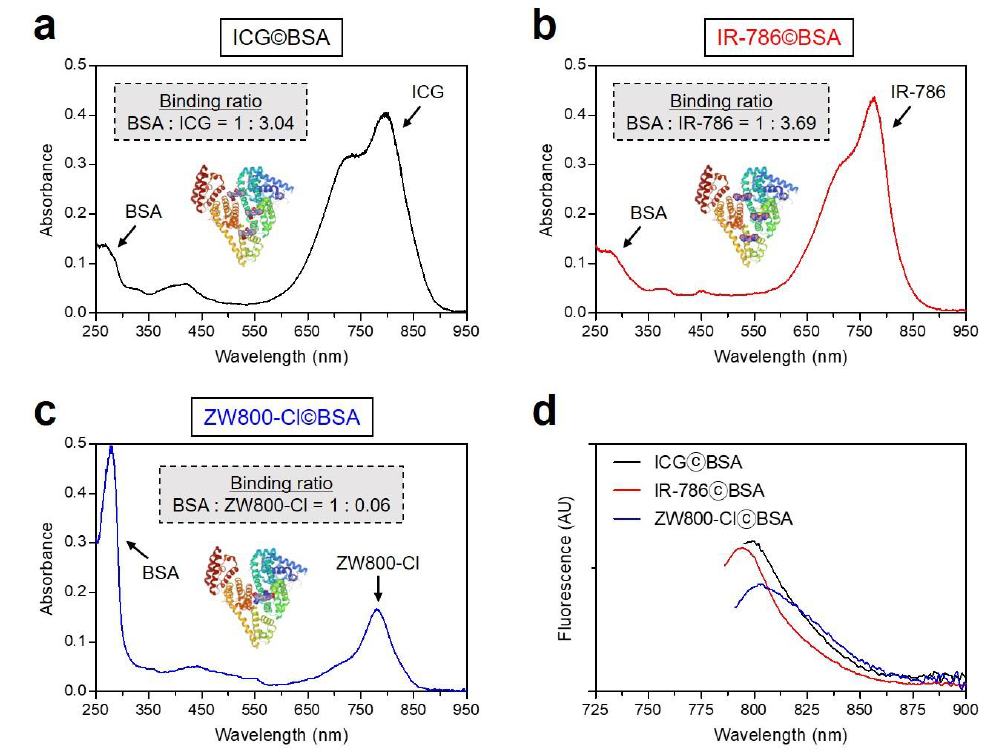
Figure 3. Absorption spectra of ( a ) ICG©BSA, ( b ) IR-786©BSA, and ( c ) ZW800-Cl©BSA complexes, and ( d ) their fluorescence emission spectra. The sample was obtained from the 1st peak fraction as shown in Figure 2. Optical measurements were performed in PBS, pH 7.4. The binding ratio of each dye©BSA complex was calculated by the molar extinction coefficient and absorbance peak of each dye and BSA, as follows: Binding ratio = (Abs dye max / ε dye )/[(Abs 280 nm − CF × Abs dye max )/ ε BSA ], CF = correction factor: ICG = 0.02, IR-786 = 0.04, ZW800- Cl = 0.02, ε BSA = 43,824 M − 1 cm −1 .